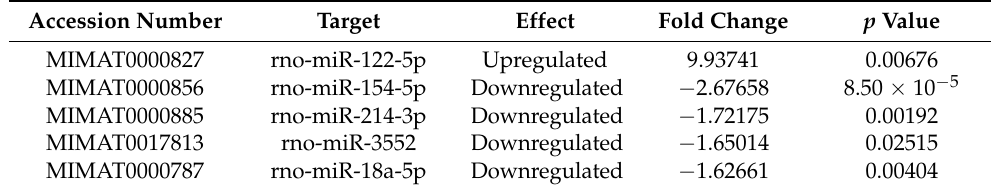
Table 1. List of differentially expressed miRNA targets in the adult rat ovary as a result of prenatal THC exposure.